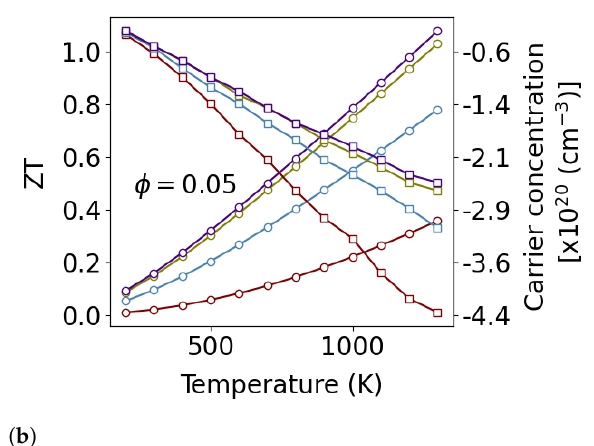
Figure 7. Plots of the maximum ZT that can be obtained by tuning the carrier concentration at each temperature. The data plotted with circles is the ZT and corresponds to the left hand axis, while data plotted with squares is the carrier concentration that produces the best ZT . The red line is for monolithic single crystal Si 0.8 Ge 0.2 , the same material containing porosity φ in the form of cylindrical pores with a 20 nm spacing in blue, and polycrystalline Si 0.8 Ge 0.2 , with 20 nm grain size in green, and polycrystalline material with the 20 nm grain size and pores with a 20 nm spacing is plotted in purple. The top plot ( a ) shows 25% porosity, while plot ( b ) shows 5%